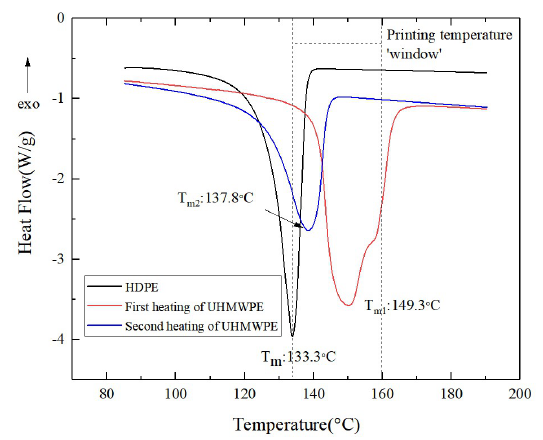
Figure 2. DSC thermograms of UHMWPE and HDPE.